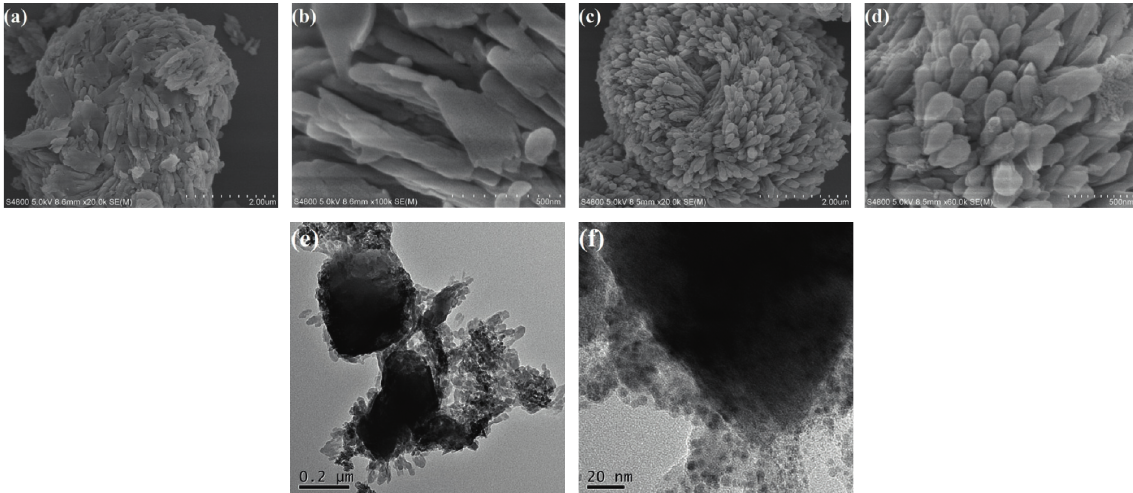
Figure 3: SEM images for (a, b) HPW@CoCe-MOF, (c, d) HPW@CoCeO, and TEM images of (e, f)